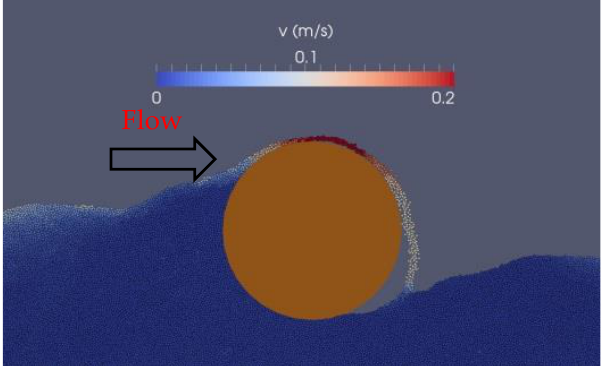
Figure 3. Flow and sediment transport around a subsea pipeline coloured by the flow velocity [86].